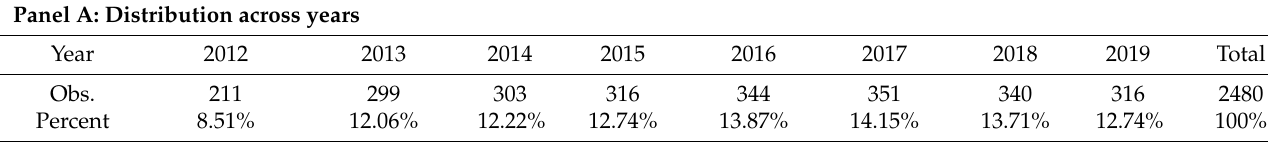
Table 1. Sample distribution across years and industry